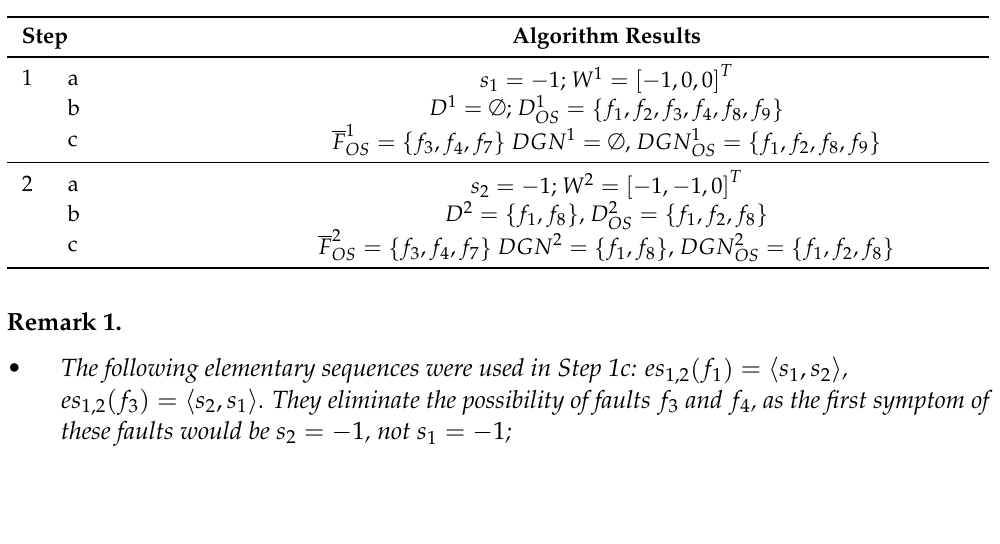
Table 10. The results of the algorithm for the input signals from Figure 3.